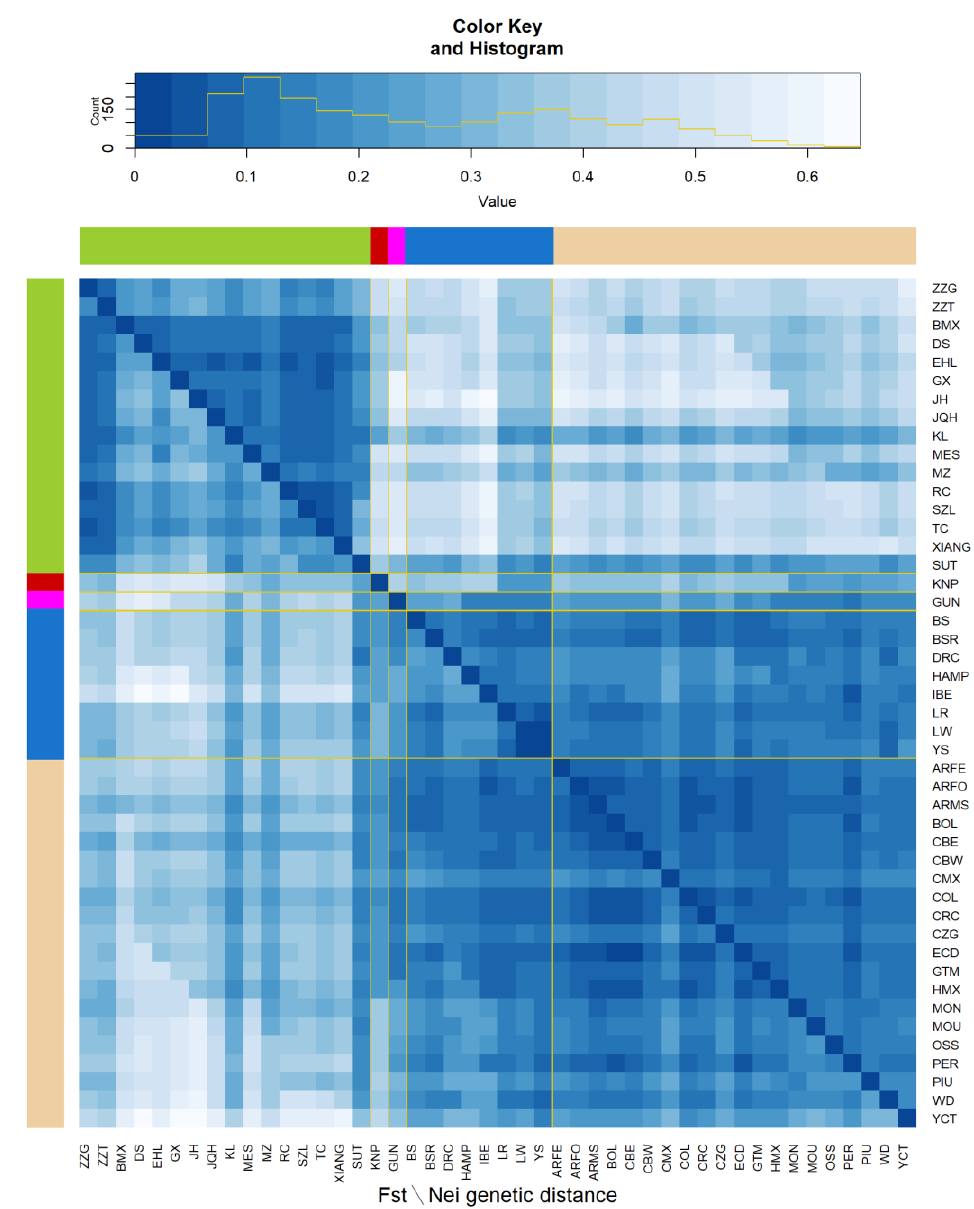
Figure 5. Heat map used to derive F ST and Nei’s genetic distance values for the Chinese populations (olive green), KNP (red), American guinea hog (magenta), European populations (blue), and American populations (off-white). (Argentina Feral (ARFE), Argentina Formosa Semi Feral (ARFO), Argentina Misiones Creole (ARMS), Bamaxiang (BMX), Bolivia Creole (BOL), Berkshire (BS), Bisaro (BSR), Cuba Eastern Creole (CBE), Cuba Western Creole (CBW), Mexico Cuino (CMX), Colombia Creole (COL), Costa Rica Creole (CRC), Colombia Zungo (CZG), Duroc (DRC), Dongshan (DS), Ecuador Creole (ECD), Erhualian (EHL), Guatemala Creole (GTM), Guinea Hog (GUN), Ganxi (GX), Hampshire (HAMP), Mexico Hairless (HMX), Iberian (IBE), Jinhua (JH), Jiangquhai (JQH), Kele (KL), Korean Native (KNP), Landrace (LR), Large White (LW), Meishan (MES), Brazil Monteiro (MON), Brazil Moura (MOU), Min (MZ), Ossabaw (OSS), Peru Creole (PER), Brazil Piau (PIU), Rongchang (RC), Sutai (SUT), Shaziling (SZL), Tongcheng (TC), White Duroc (WD), Xiang Pig (XIANG), Yucatan (YCT), Yorkshire (YS), Tibetan Gansu (ZZG), Tibetan Tibet (ZZT).)